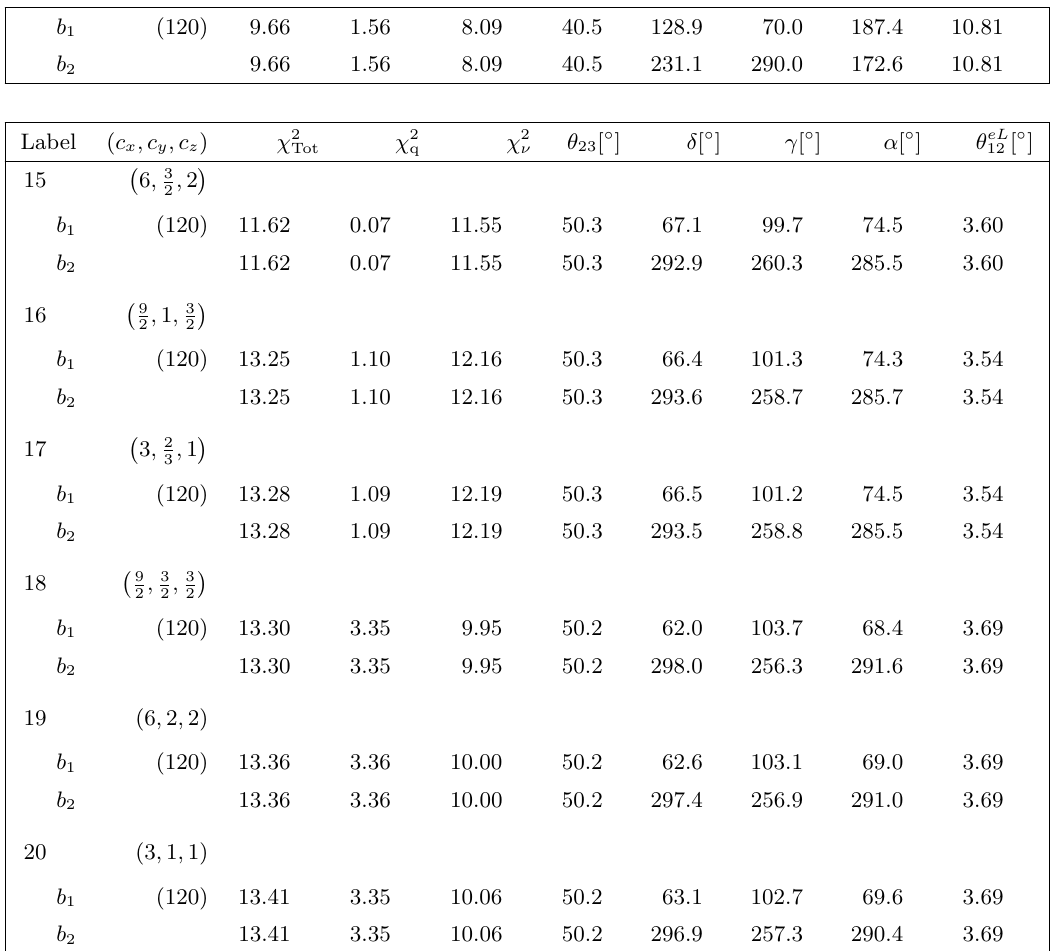
Table 2. Results of the (cid:12)t for model candidates speci(cid:12)ed by the CG coe(cid:14)cients and the CSD2 scenario. The table shows a complete list of CG coe(cid:14)cients ( c x ; c y ; c z ) with (cid:31) 2 < 15, ordered according to their best (cid:31) 2 value. For each combination of ( c x ; c y ; c z ) and CSD2 scenario ( Y (102) (cid:23) or Y (120) (cid:23) ) all local minima with (cid:31) 2 < 15 are listed. The 1st column assigns a unique label to each local minimum. The 2nd column speci(cid:12)es the CG coe(cid:14)cients and the type of neutrino Yukawa coupling. The quantity (cid:31) 2 indicates the (cid:31) 2 of the model, which includes all observables. (cid:31) 2 Tot contributions of the (cid:31) 2 coming from the quark and charged lepton Yukawa couplings and the CKM parameters, whereas in (cid:31) 2 the remaining contributions to the (cid:31) 2 from the neutrino mass squared (cid:23) di(cid:11)erences and the PMNS angles are incorporated. In the last (cid:12)ve columns the values of the two observables (cid:18) 23 (cid:17) (cid:18) PMNS , (cid:14) (cid:17) (cid:14) PMNS , the two parameters (cid:13) , (cid:11) and the 1{2 left angle (cid:18) eL 23 charged leptons are